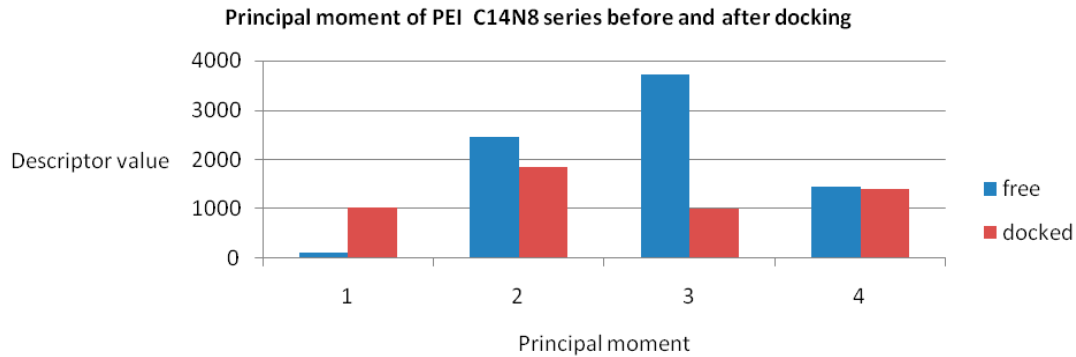
Figure 7. Principal moment of inertia in the C14N8 PEI series before (free of docking) and after docking. Figure 8 shows the molecular models of the LPEI C14N8 structure, represented before and after docking with GOx; the changes in molecule geometry are clearly seen.